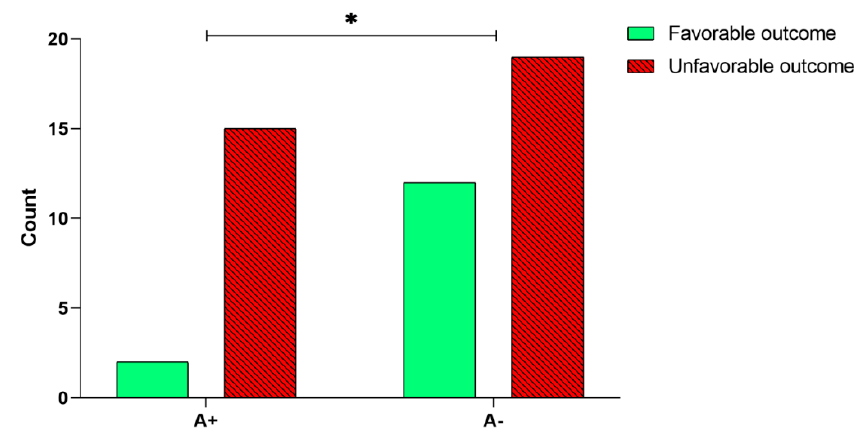
Figure 3. Analysis of BDNF rs6265 polymorphism and the rehabilitation outcome. Number of patients carrying A + and A − alleles that obtained a favorable outcome after the 30-session rehabilitation intervention. The asterisk indicates a statistically significant di ff erence: * p < 0.05, according to the χ 2 test. Table 2. Logistic regression model.